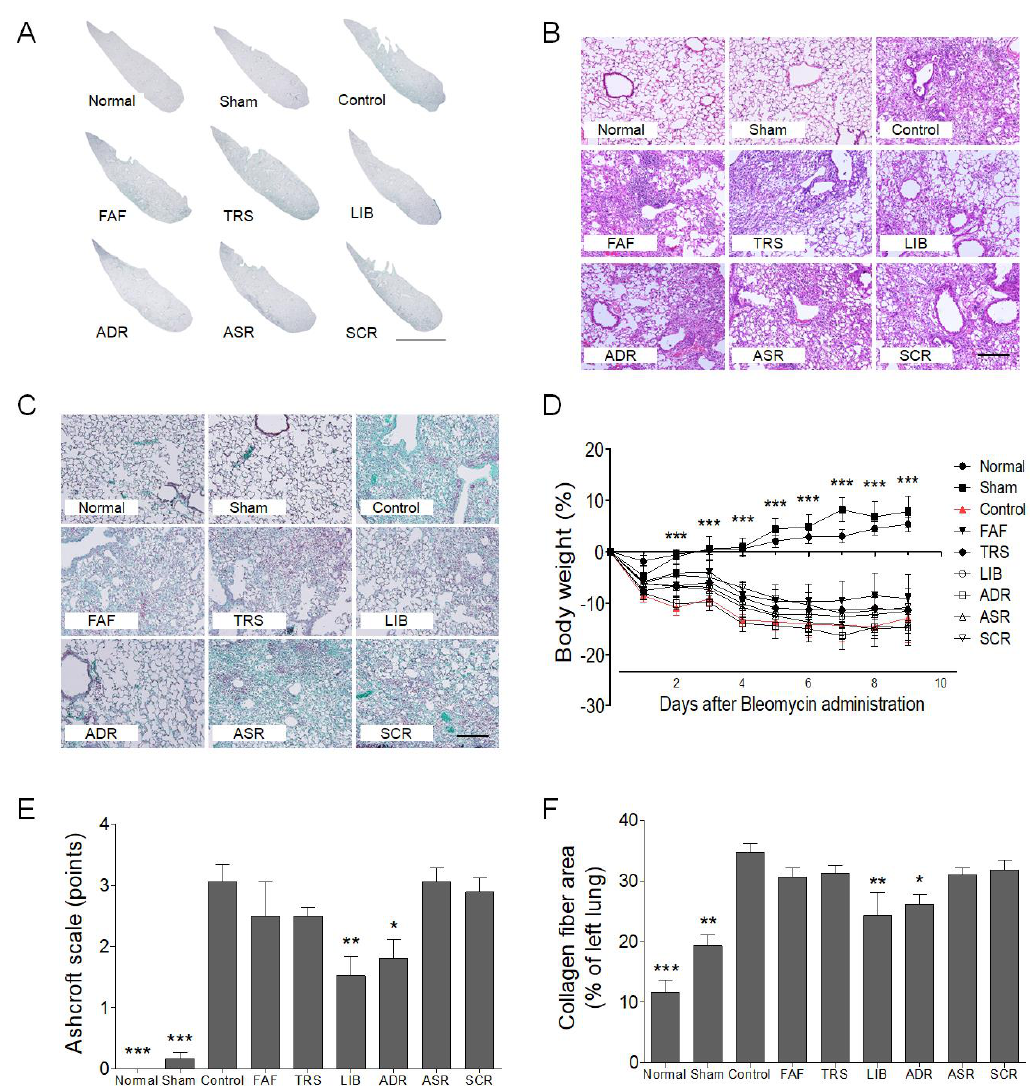
Figure 1. Effects of herbal medicines used to treat pulmonary fibrosis on Masson’s trichrome-stained left lung (10×, A ), Hematoxylin-Eosin-stained lung sections (200×, B ), Masson’s trichrome-stained lung sections (200×, C ), body weight ( D ), Ashcroft score ( E ), and collagen fiber area of left lung ( F ). Scale bars are 1 mm ( A ) and 400 μm ( B,C ), respectively. FAF, Farfarae Flos; TRS, Trichosanthis Semen; LIB, Lilii Bulbus; ADR, Adenophorae Radix; ASR, Asteris Radix; SCR, Scrophulariae Radix. * represents statistical differences from control group (* p < 0.05, ** p < 0.01, *** p < 0.001). Eleven days after lung fibrosis, the number of total cells, macrophages, and lymphocytes in BALF of the control group increased compared to that in normal and sham groups ( p < 0.001). All